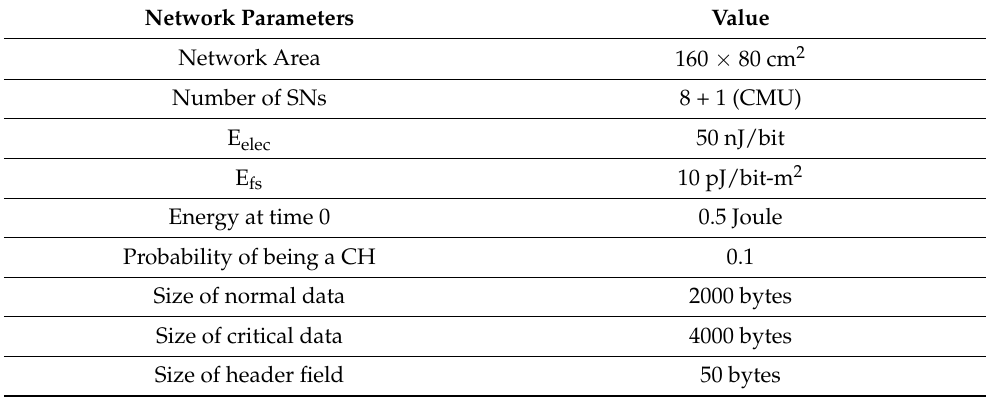
Table 3. Demonstrates the network parameters.